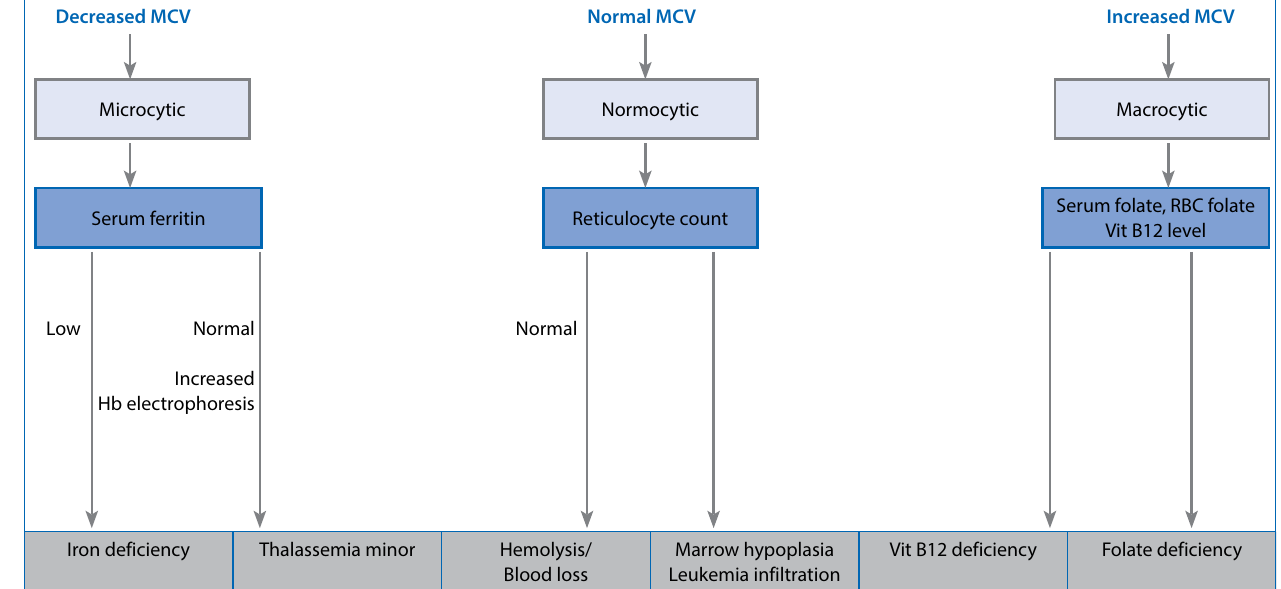
Figure 5. Diagnosis and identifying the type